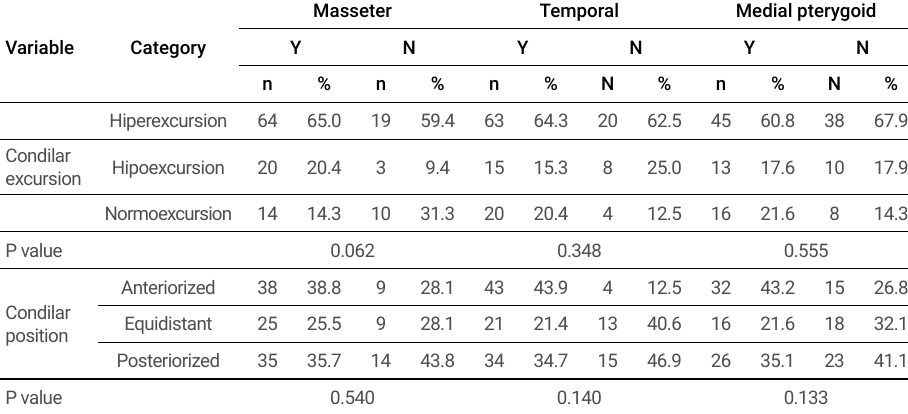
Table 4. Cross tabulation of the excursion estimates, condylar positions, muscular signs and the significance of the chi-square test.